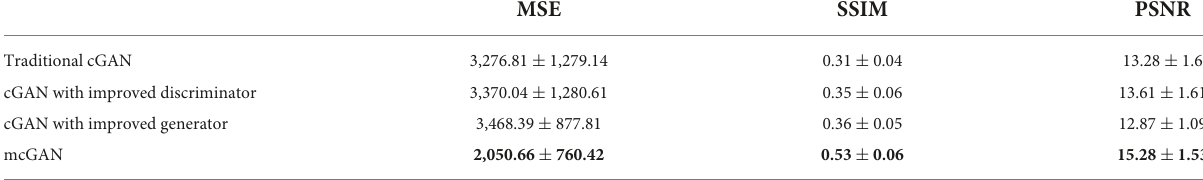
TABLE 3 Face reconstruction performance with varied generator and discriminator of generative adversarial networks (GAN)